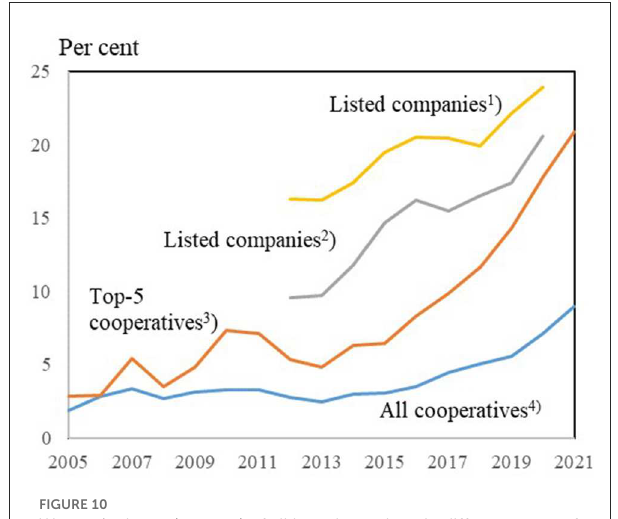
FIGURE10 Women’s shares (percent) of all board members in different types of companies in Denmark. 1 Elected by the general meeting and by employees in listed companies. 2 Elected by the general meeting. 3 Elected (total) in farmer-owned Danish farmer-cooperatives: Five biggest cooperatives. 4 Elected (total) in farmer-owned Danish farmer-cooperatives: All cooperatives. Sources: Own calculation and presentation based on (25) and annual reports from